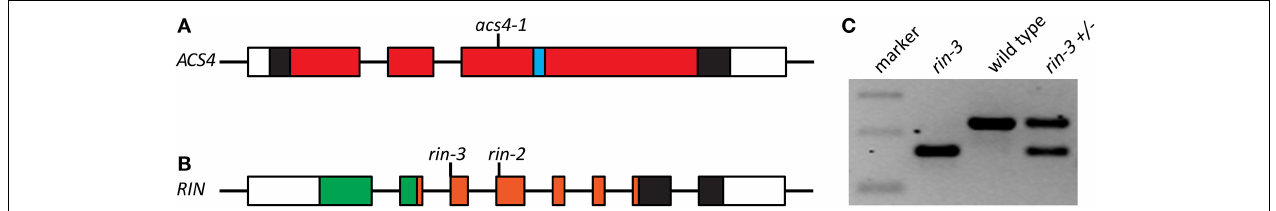
FIGURE 1 | Gene models and mutant description. Gene models of ACS4 (A) and RIN (B) , indicating the sites of mutations in the alleles presented in this study. Exons are indicated as boxes and depicted in relative sizes, introns not. Coding sequence is indicated as filled boxes; red: the canonical